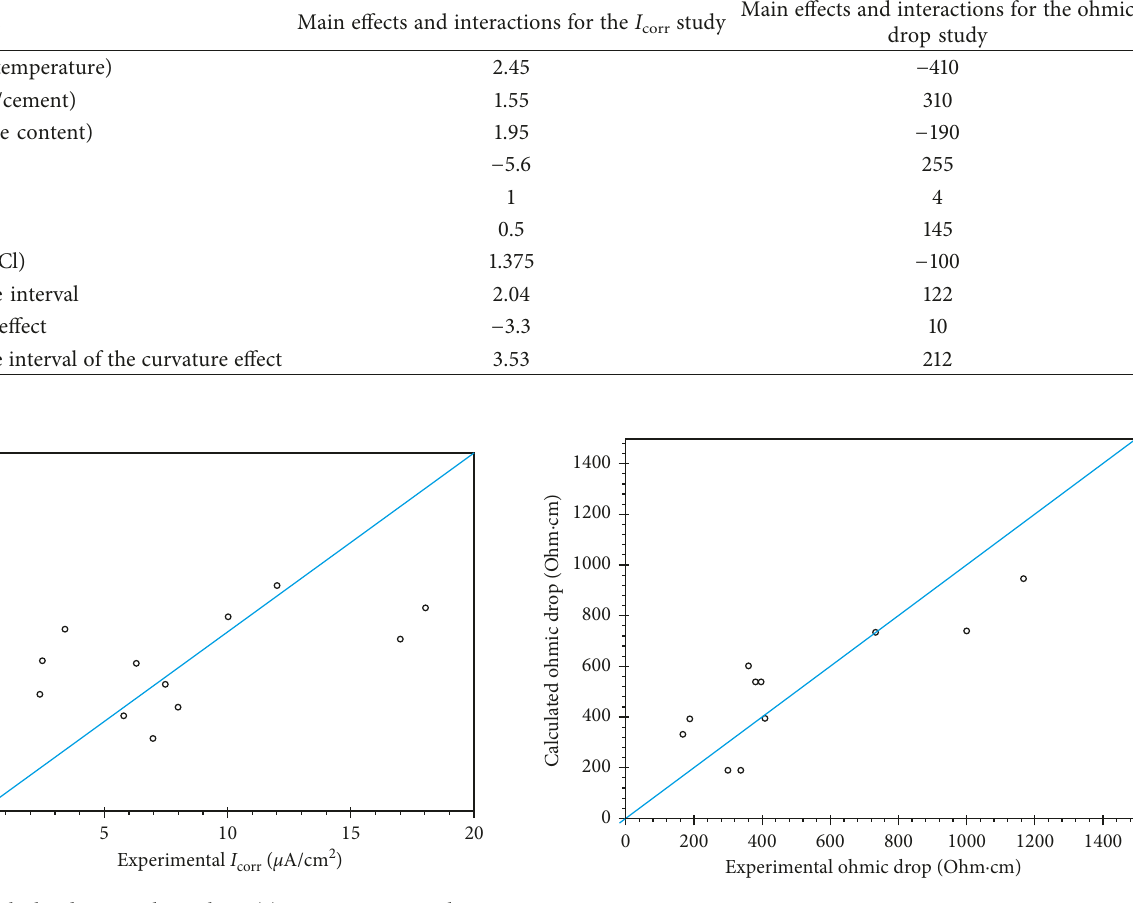
Figure 7: Calculated I corr resultsapplying(8)versusexperimental I corr . Figure 8: Calculated ohmic drop results applying (9) versus ex- perimental ohmic